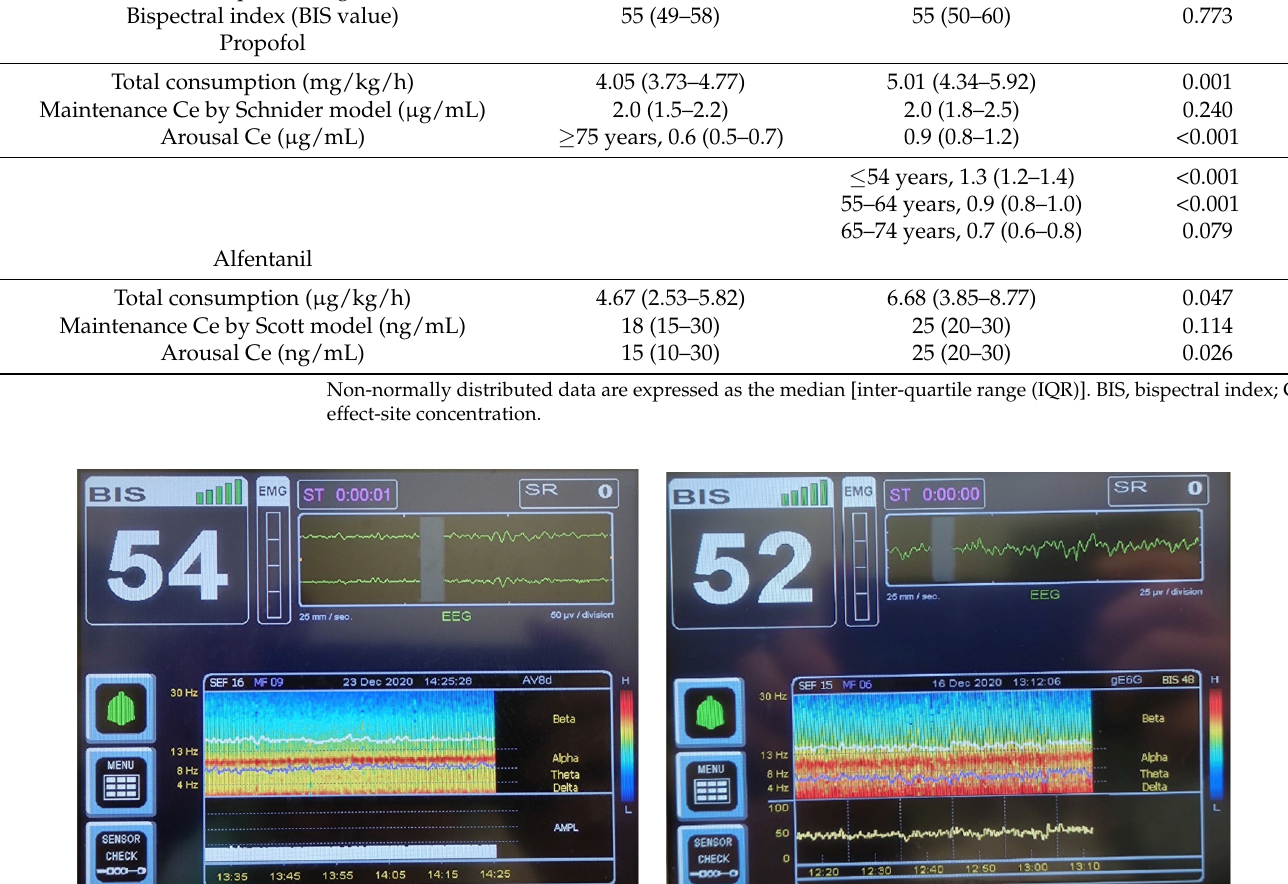
Figure 3. Upper airway position of patients for non-intubating anesthesia. Left: 15 ° head-down tilt only. Middle: 15 ° head-down tilt with a neck roll pillow (indicated by the red circle). Right: 15 ° head- down tilt with a neck roll pillow and keeping the chin plane horizontally aligned by a headrest (indicated by the red square) to be able to optimize respiratory impedance. 2.6. Primary and Secondary Outcomes The primary outcome was to investigate and compare the arousal and maintenance of propofol Ce using EEG DSA in elderly and late-elderly patients who underwent LVA. In addition, we classified the elderly group into three subgroups (<54-years-old, 55 − 64- years-old, and 65 − 74-years-old) and compared them with the late-elderly group (>75- years-old). Five additional intraoperative secondary outcomes were assessed and com- pared between both groups, including the operation time, intraoperative respiratory rate, pulse oximetry, BIS values, and urine output. Other secondary outcomes included post- operative volume reduction, nausea and vomiting (PONV), delirium, cognitive dysfunc- tion, respiratory complications, and cardiovascular events. 2.7. Statistical Analysis The normality of continuous numeric data was assessed using the Kolmogorov– Smirnov normality test. Student’s t -test was used to compare normally distributed varia- bles, presented as the mean ± standard deviation. The Mann–Whitney U test was used to